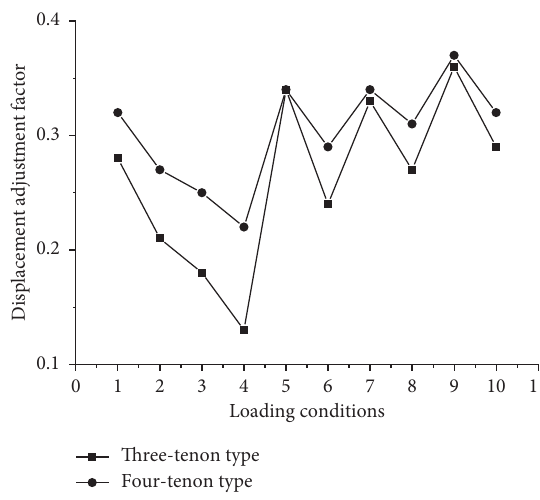
Figure 9: Results of displacement adjustment coefficient.